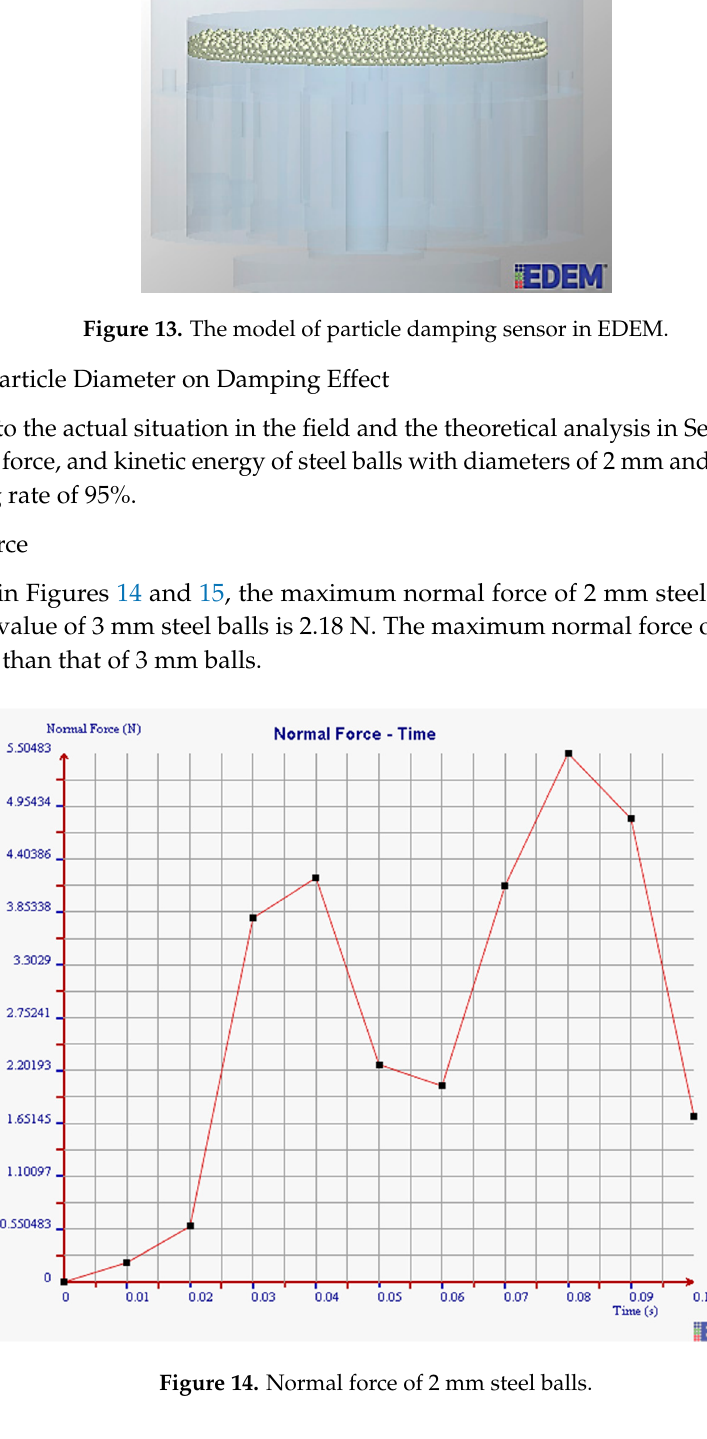
Figure. 15 Normal force of 3 mm steel balls. (2) Tangential Force It can be seen from Figures 16 and 17 that the maximum tangential force of 2 mm steel balls within 0.1 s is 0.67 N, and the value of 3 mm steel balls is 0.28 N. The maximum tangential force of 2 mm steel balls is 2.39 times more than that of 3 mm balls.